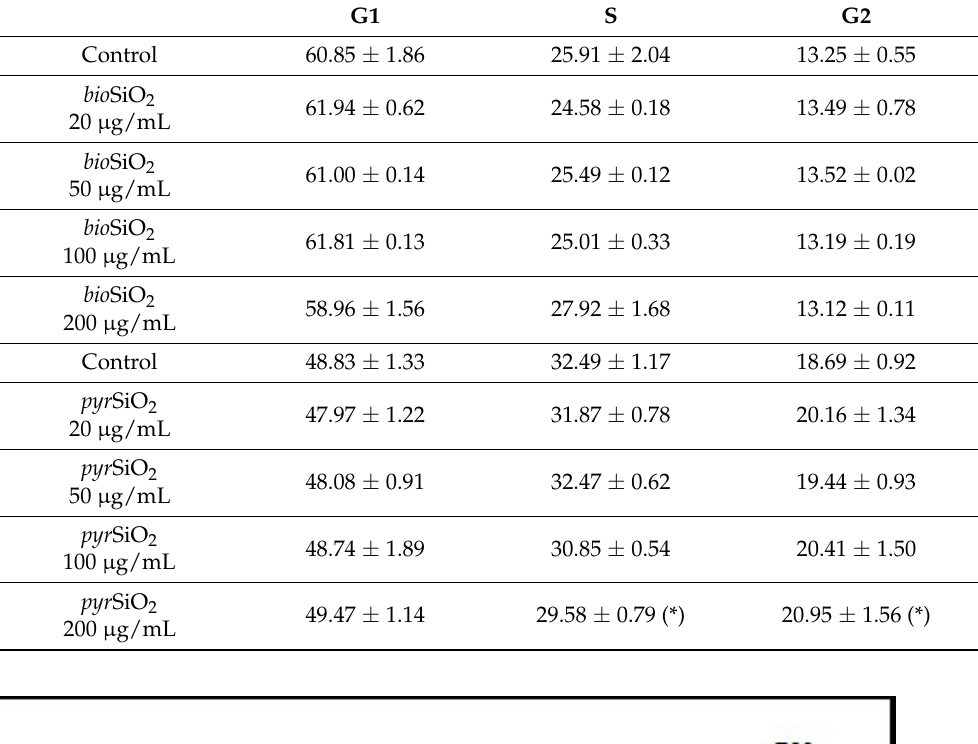
Table 1. The effect of the silica nanoparticles on the cell cycle. The percentage of the distribution of the G1, S, and G2 stages of the HMEC-1 cell cycle after 72 h of incubating cells with nanosilica. Statistical evaluation of differences was conducted using the ANOVA I and Tukey’s post hoc tests, at significance levels of p < 0.01 (*) with respect to the control.